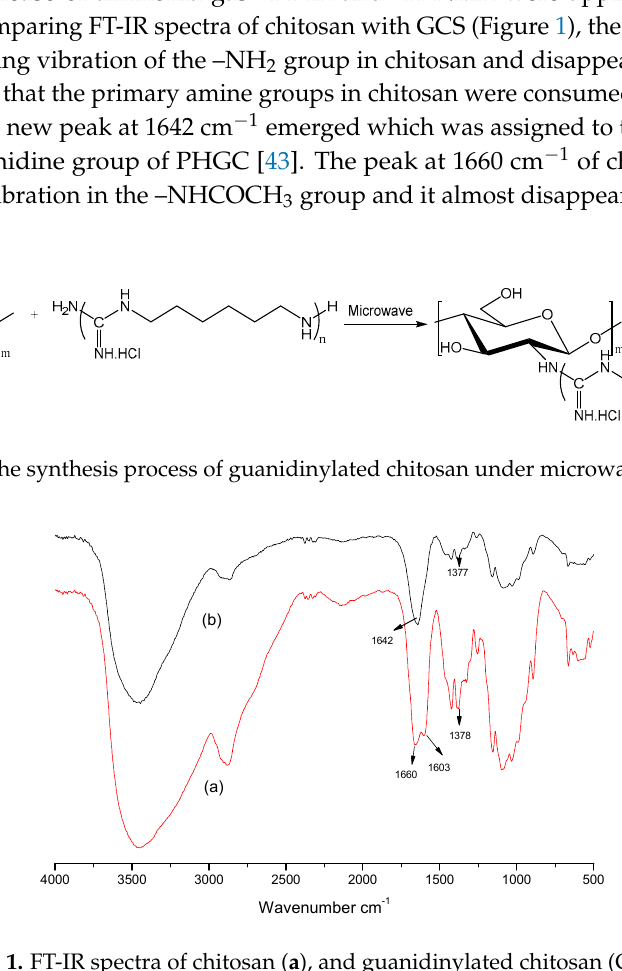
Figure 1. FT-IR spectra of chitosan ( a ), and guanidinylated chitosan (GCS) ( b ).